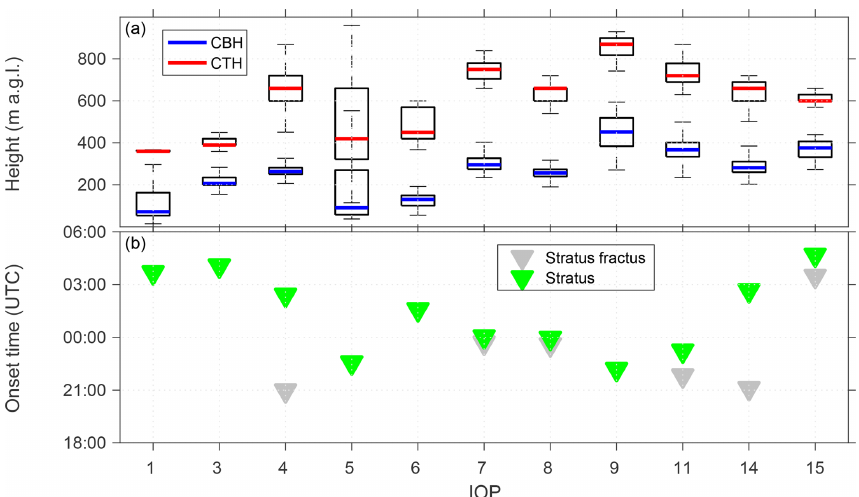
Figure 5. Cloud-base height (CBH) and cloud-top height (CTH) during the stratus phase (a) . The blue and red bars indicate median CBH and CTH, respectively, the top and bottom edges of the boxes represent the 75th and 25th percentiles and the whiskers extreme values. Onset time of stratus and stratus fractus (if it occurred) estimated from ceilometer measurements derived with the methods described in Sect. 2.2.2 (b)